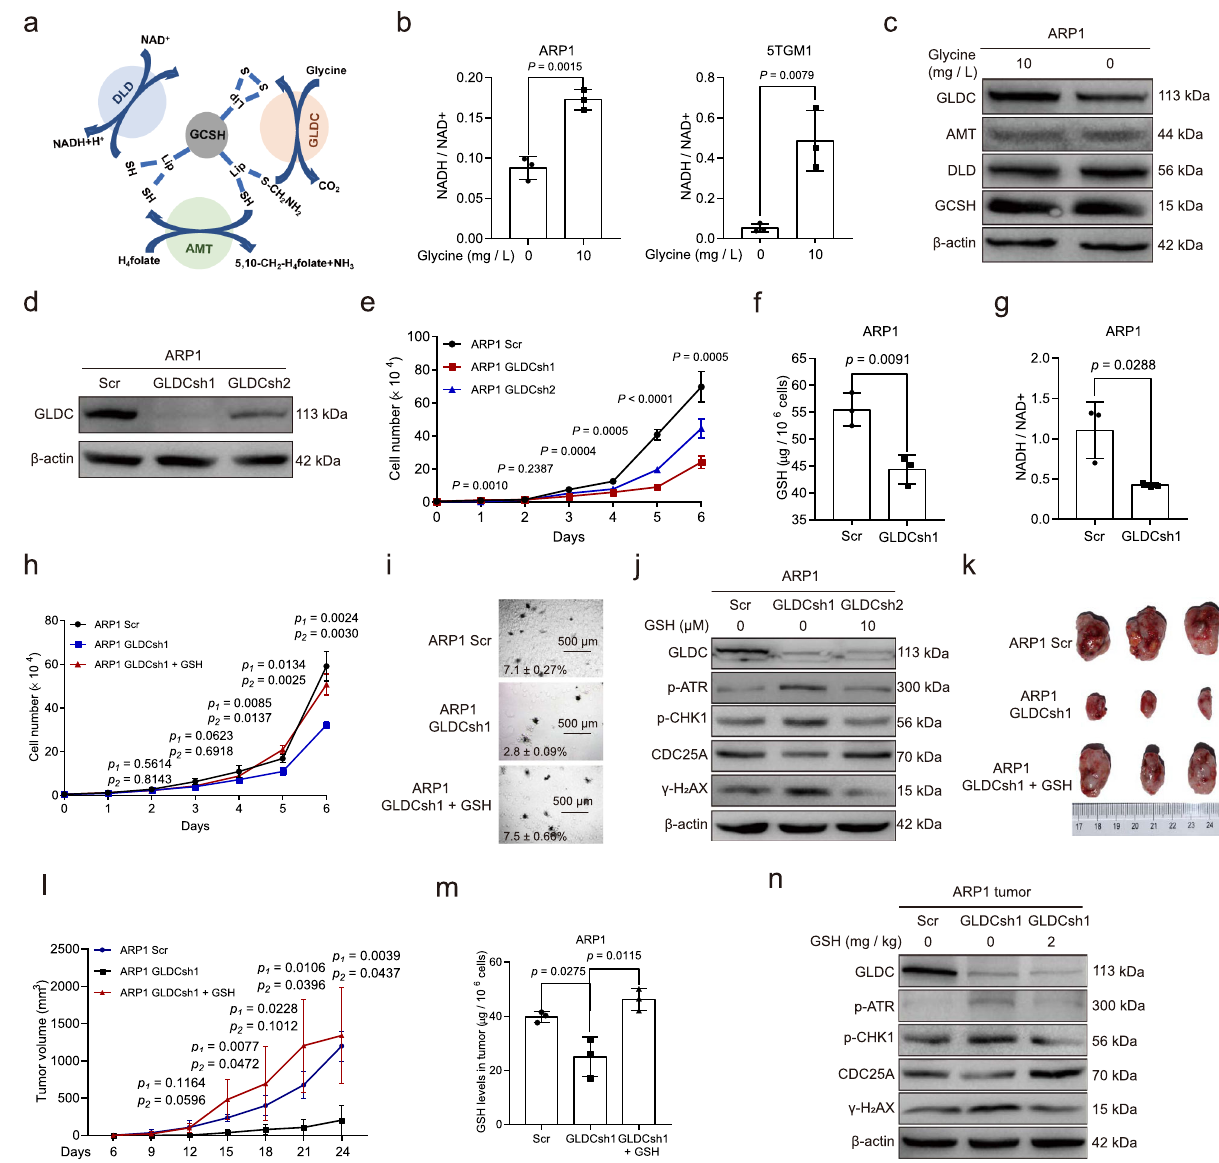
Fig. 4 Knockdown of GLDC impairs the proliferation of MM cells. a Schematic of the glycine cleavage system. b The ratio of NADH/NAD + in ARP1 and 5TGM1 cells cultured with or without exogenous glycine. c Western blotting of GLDC, GCSH, DLD, AMT, and β -actin in ARP1 cells cultured with or without glycine for 24 h. d Western blotting of GLDC and β -actin in ARP1 cells with Scramble (Scr), GLDC shRNA1 (GLDCsh1) and GLDCsh2. e Growth curves of ARP1 cells with Scr, GLDCsh1, or GLDCsh2. f GSH levels in ARP1 cells with Scr and GLDCsh1. g The ratio of NADH / NAD + in ARP1 cells with Scr or GLDCsh1. h Growth curves of ARP1 cells with Scr or GLDCsh1 with or without GSH treatment. i Clonogenic analysis of ARP1 cells with Scr or GLDCsh1 with or without GSH treatment. n = 3 independent experiments; Results represent means ± SD; Signi fi cance was analyzed with unpaired two-sided t -test in ( b , f – h ) ( p 1 represent the signi fi cance between Scr and GLDCsh1, p 2 represent the signi fi cance between GLDCsh1 and GLDCsh1 + GSH), with ANOVA one- way test in ( e ). j Western blotting of GLDC, p-ATR, p-CHK1, CDC25A, γ -H 2 AX, and β -actin in ARP1 cells with Scr or GLDCsh1 with or without GSH. k Tumor knots developed in B-NDG mice injected with ARP1 cells with Scr ( n = 3 mice), GLDCsh1 without GSH treatment ( n = 3 mice), or GLDCsh1 cells with GSH treatment (2 mg/kg) ( n = 3 mice). l Analysis of tumor volumes in Scr, ARP1 GLDCsh1, and ARP1 GLDCsh1 + GSH mice. m GSH levels in tumor knots derived from Scr, ARP1 GLDCsh1, and ARP1 GLDCsh1 + GSH mice. n = 3 mice; Results represent means ± SD; Signi fi cance was analyzed with an unpaired two-sided t -test in ( l ) ( p 1 represent the signi fi cance between Scr and GLDCsh1, p 2 represent the signi fi cance between GLDCsh1 and GLDCsh1 + GSH), m . n Western blotting of GLDC, p-ATR, p-CHK1, CDC25A, γ -H2AX, and β -actin in tumor knots derived from Scr, ARP1 GLDCsh1, and ARP1 GLDCsh1 + GSH mice. Source data are provided as a Source Data fi